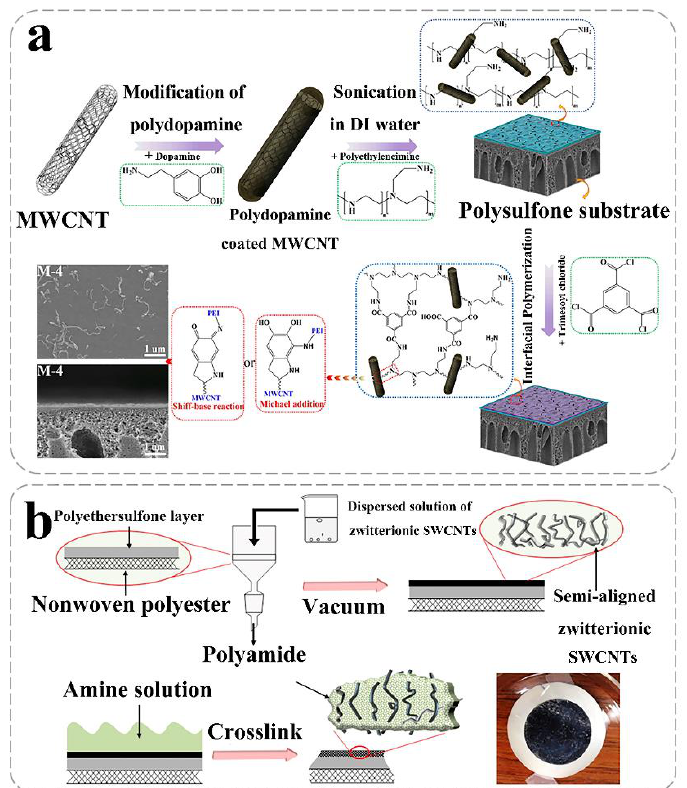
Figure 5. Preparation of composited CNT membranes. ( a ) Schematic preparation of positively